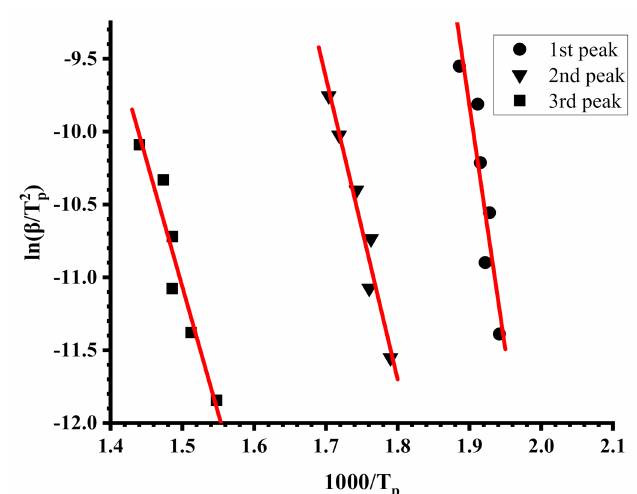
Figure 8. Kissinger plots for sample